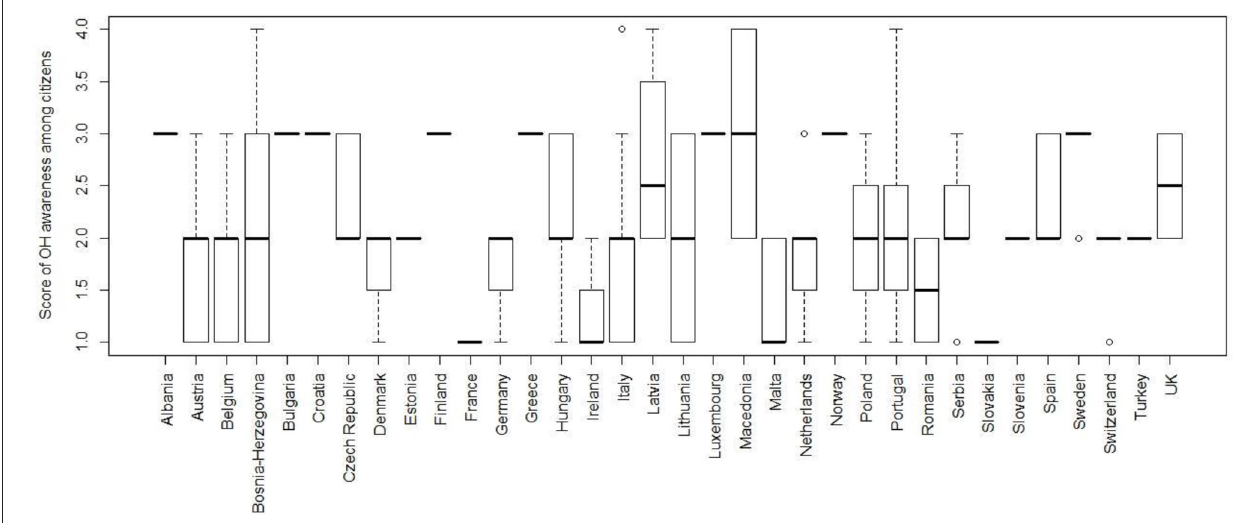
FIGURE 9 | Boxplot of the scores attributed by respondents to the level of awareness on OH in citizens in their respective countries; scoring from one (poor) to four